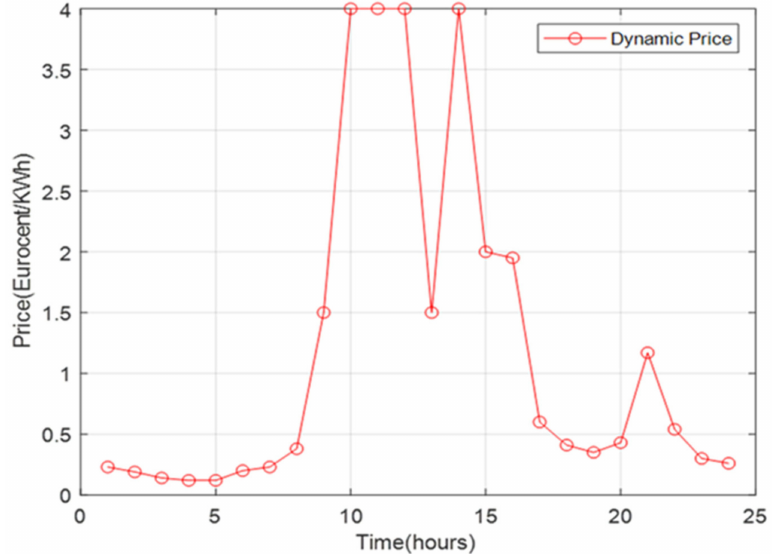
Figure 6. Dynamic pricing of the grid on an hourly